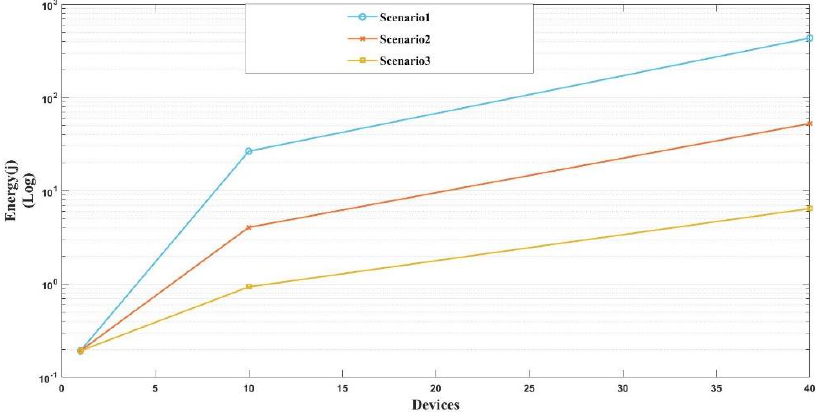
Figure 4. Energy consumption for nodes 1, 10, and 40—when distance is 200 m.